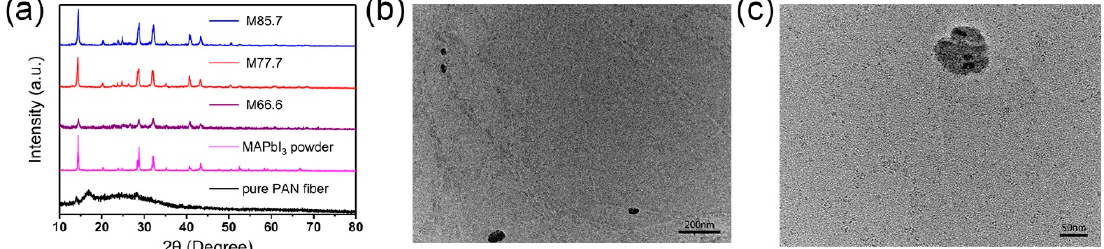
Figure 4. XRD and TEM profiles of the composite fibers. ( a ) XRD of the composite fibers, MAPbI 3 powder and pure polyacrylonitrile (PAN), and ( b , c ) TEM images of the composite fibers.